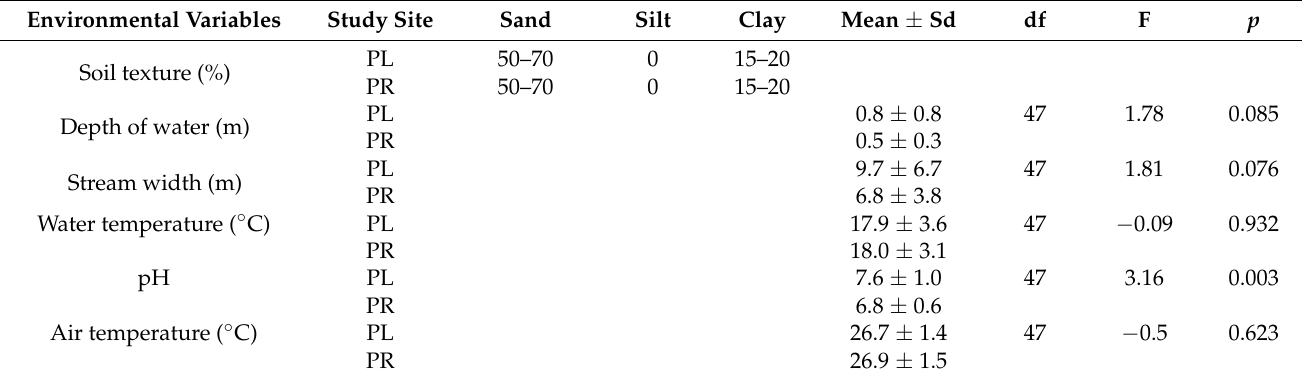
Table 1. Physical characteristics of the streams and the weather in Phu Luang Wildlife Sanctuary (PL) and Phu Ruea National Park (PR) between February 2018 and January 2019.